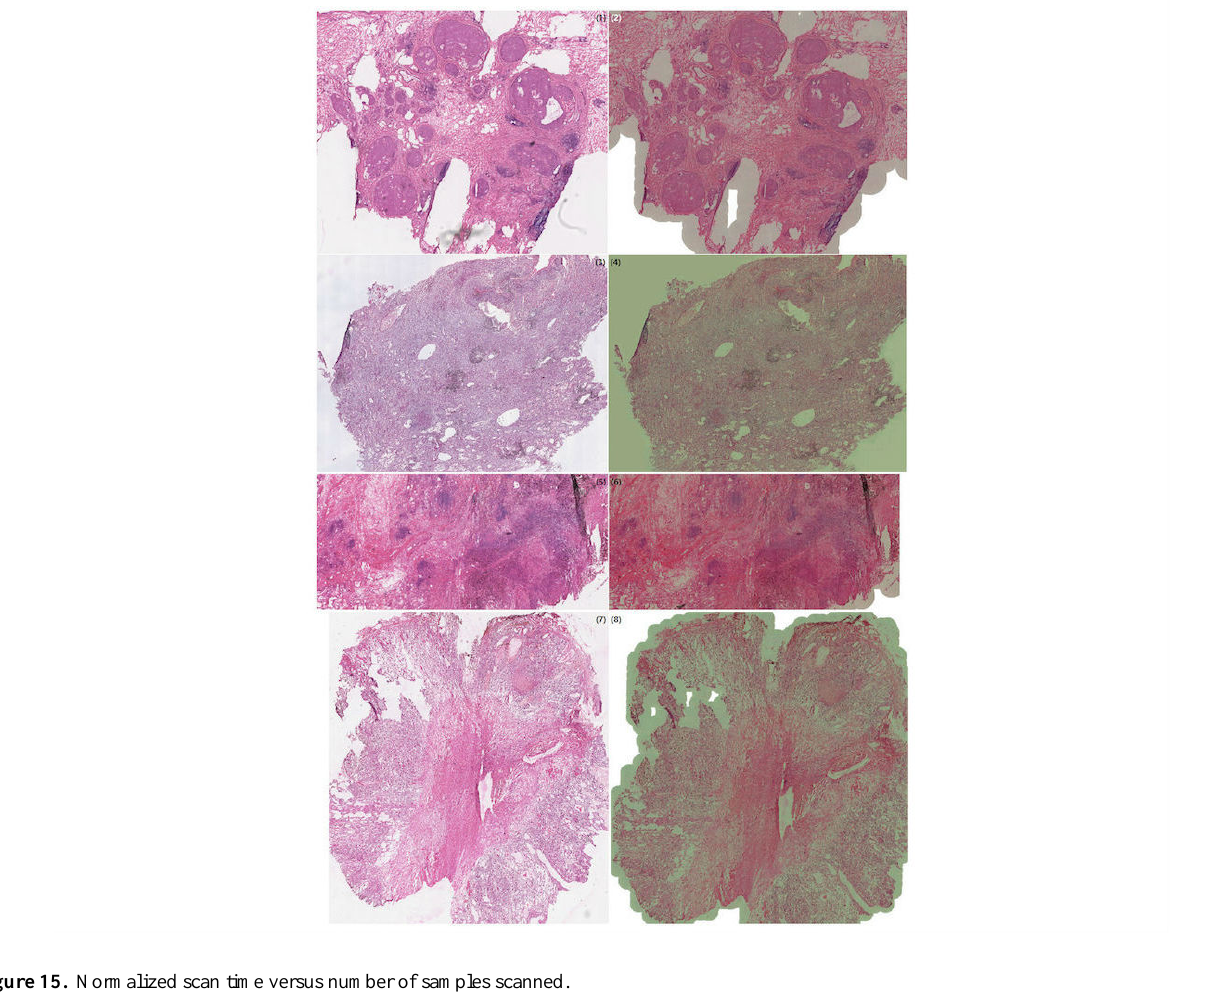
Figure 14. Selected virtual slide regions from sWSI (right) with poor quality, compared to those from the Leica scanner (left).